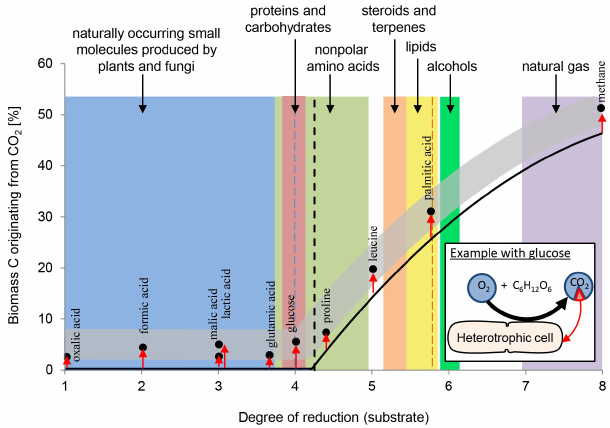
Figure 2. Anaplerotic CO 2 fixation contributes 1%–8% of carbon biomass (indicated by the grey band) in heterotrophic cells. Depen- dent to the organism and in relation to the uptake of the individual organic compounds and their entry into the TCA cycle and central metabolic pathways the relative amount of inorganic carbon assim- ilated varies, as highlighted by the red arrows. See examples for malic and lactic acid. With organic carbon sources more reduced than the organism’s biomass (dashed line) further carboxylation re- actions are induced (indicated by black line), increasing the overall carbon contribution from CO 2 beyond anaplerosis (grey band). In methanotrophs, 50% of the cell’s carbon may originate from CO 2 fixation. For further explanations, see